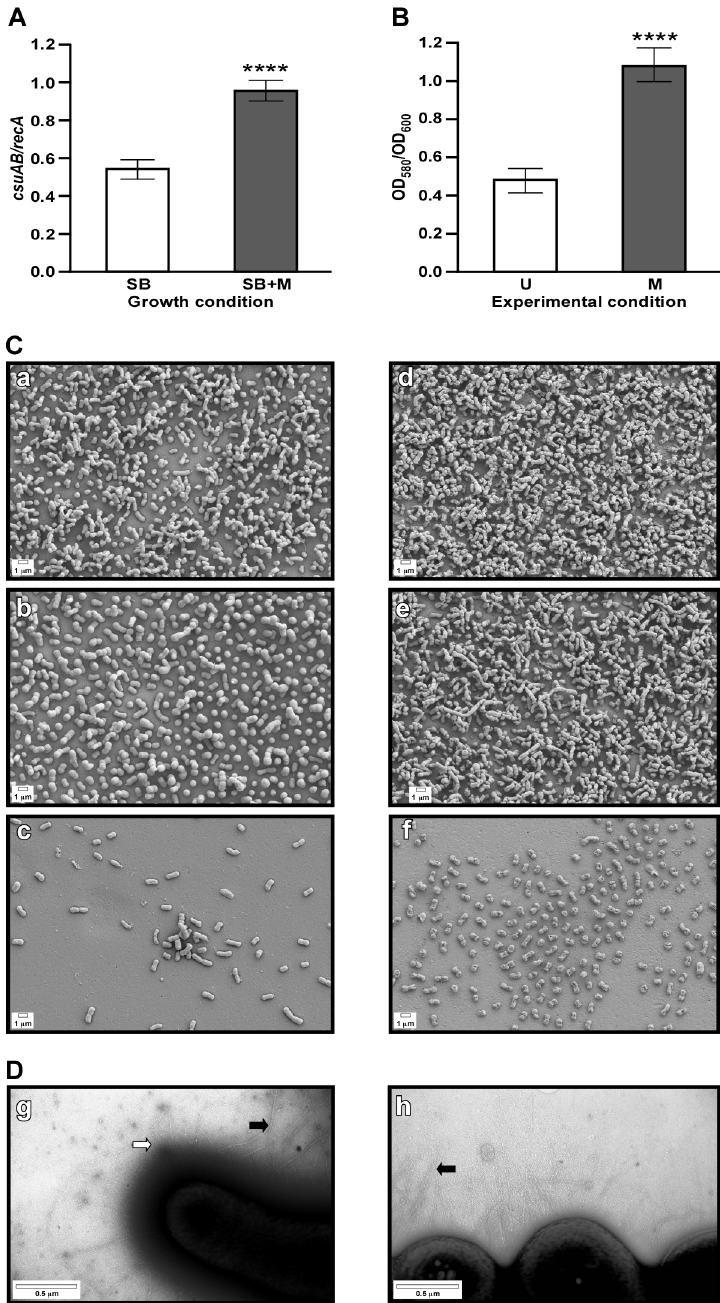
Fig 6. Effect of mucin on the expressionof the csuAB gene, biofilm formation on plastic and pili production. (A) qRT-PCR analysisof csuAB in ATCC 19606 T cells culturedin SB (white bars) or SB+M (grey bars). (B) Crystal violet staining of biofilms formed by ATCC 19606 T on uncoated(U, white bar) or mucin- coated (M, grey bar) polystyrenetubes. qRT-PCR and biofilm analyseswere performed using nine and six replicates for each study, respectively. Significantly different values ( P (cid:20) 0.0001) are identifiedby four asterisks and error bars represent the standarderror of each data set. (C) SEM of biofilms formed on uncoated(a, b, c) or mucin coated (d, e, f) coverslipsby ATCC 19606 T cells. Micrographs were taken above (a and d), at (b and e), or below(c and f) the liquid-airinterface at a magnification of 10,000x. Scale bars, 1 μ m. (D) TEM of bacterialcells lifted from the surface of SA (g) or SA supplemented with mucin (h). Micrographs were taken at a magnification of 30,000x. Scale bars, 0.5 μ m.